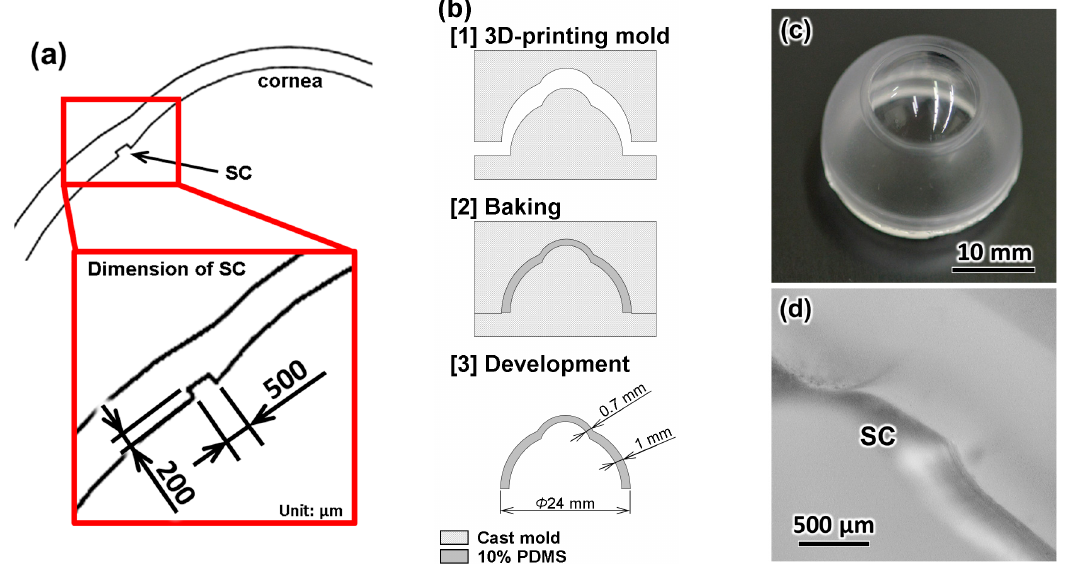
Figure 3. ( a ) Design and dimensions of eye model with 3D microchannel as artificial Schlemm’s canal (SC) ; ( b ) fabrication process of the eye model with SC; ( c ) fabricated eye model made from